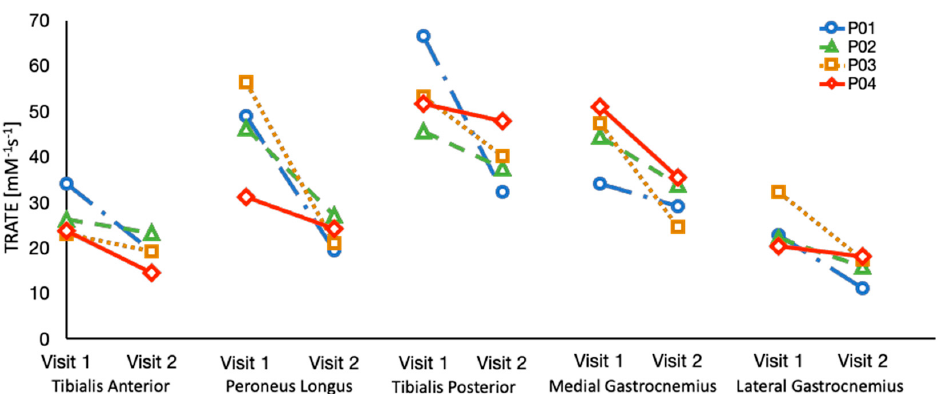
ALS affected muscle groups. affected muscle groups.